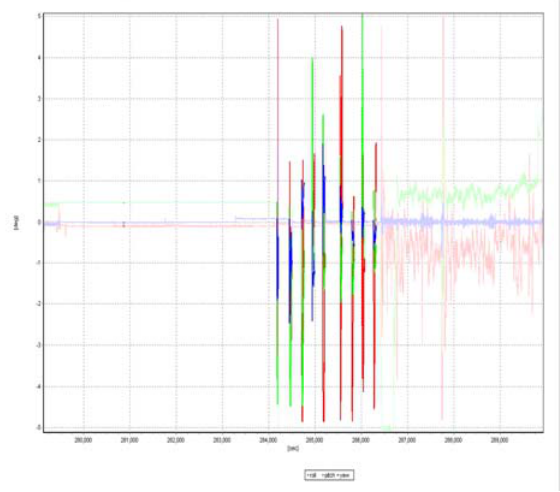
Figure 3: Corrected rotations of camera during flight